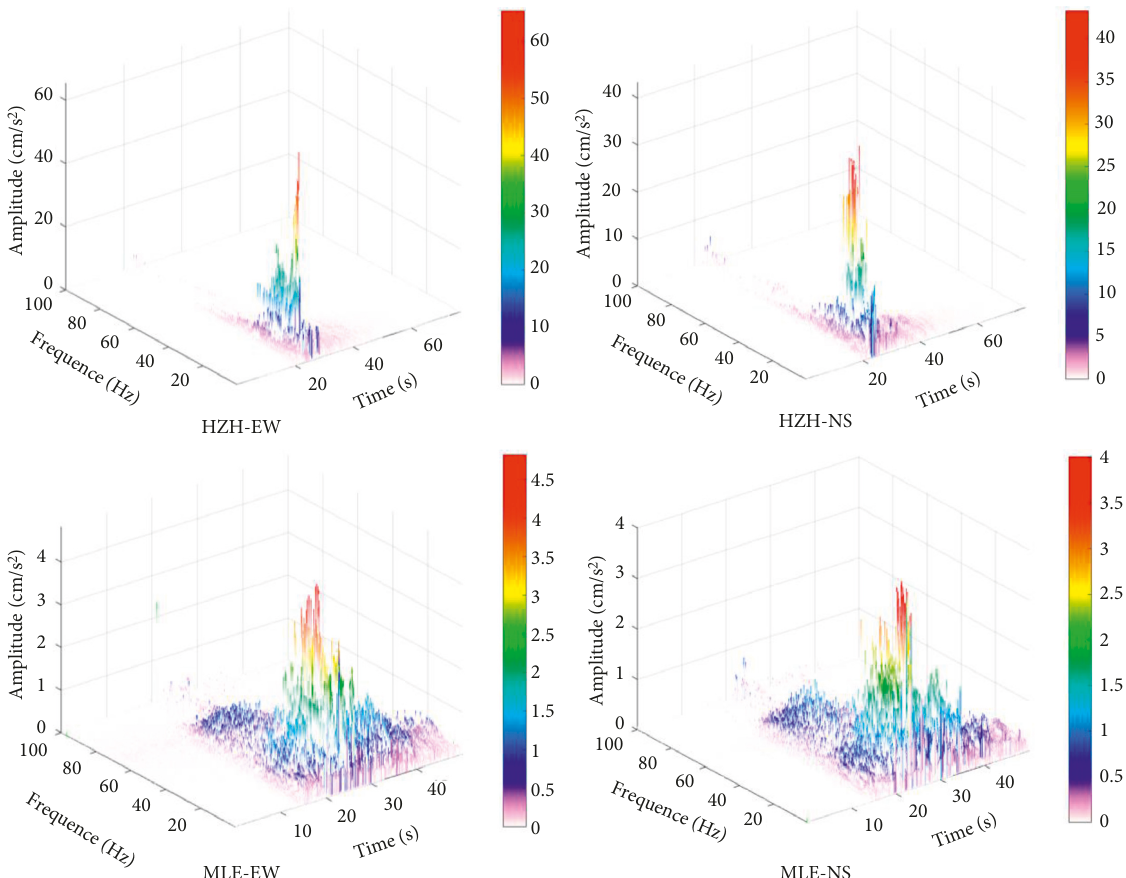
Figure 4: Hilbert-Huang spectrum of the reconstructed signal of HZH and